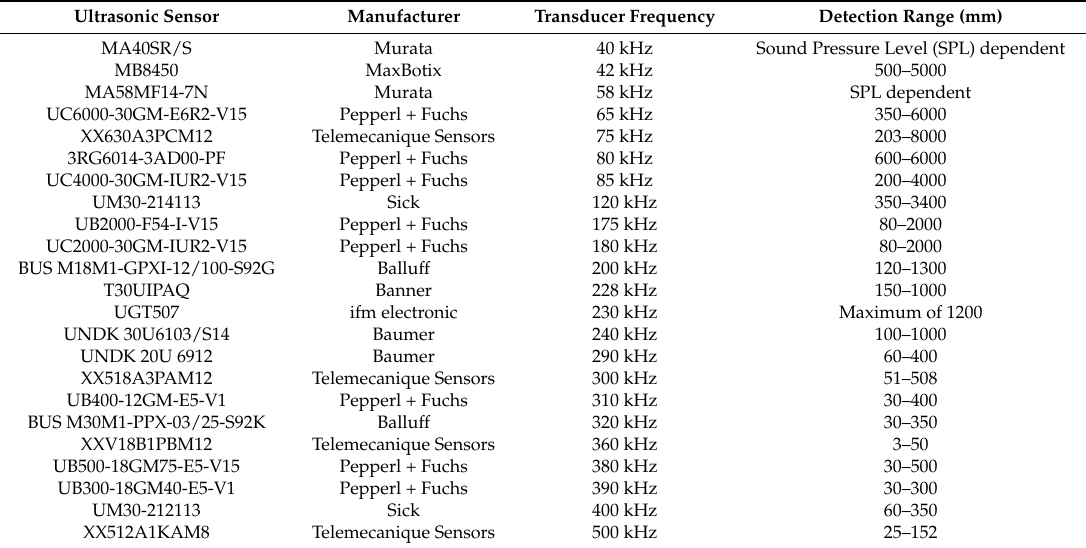
Table 4. Commercially available ultrasonic ranging